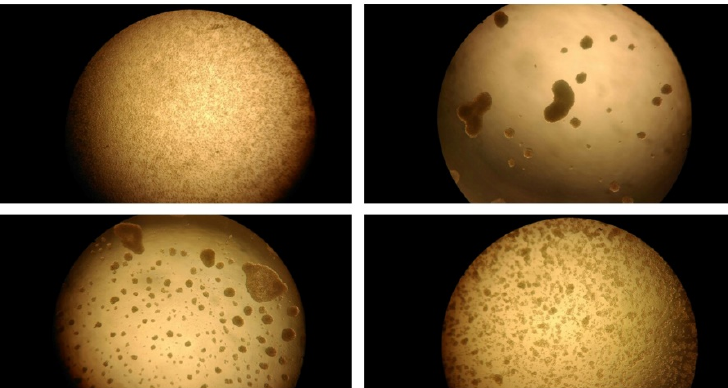
Figure 8. Optical microscope image of C8166 cells treated with different concentrations of CS/hsDNA complexes (CS MW = 50 KDa, N/P = 10): 250, 50, 10 and 0 µg/mL.